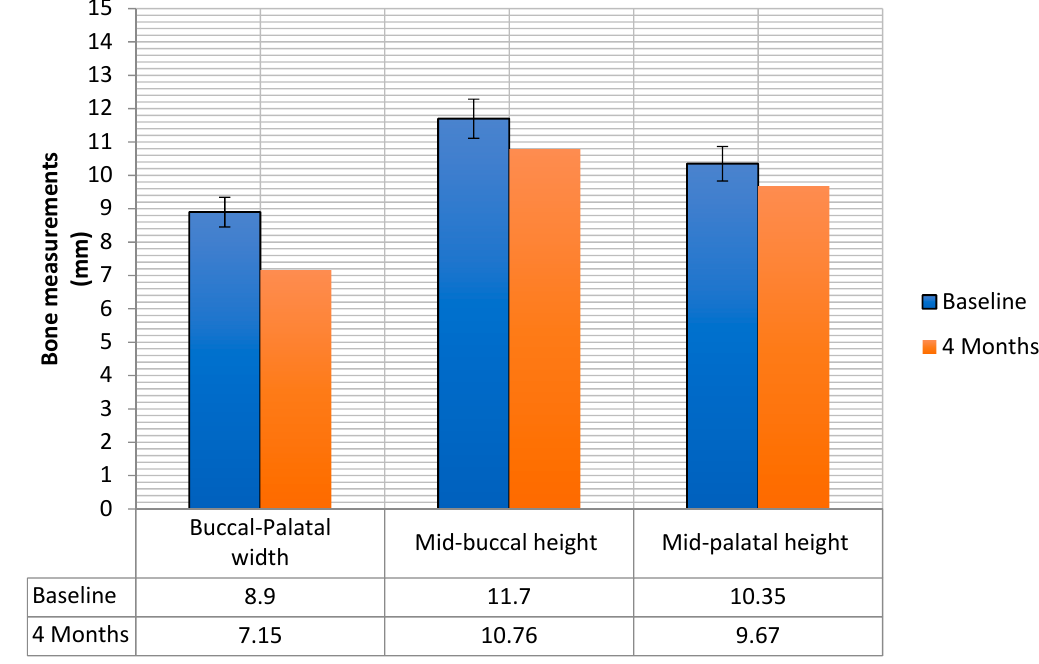
Chart 1. Dimensional changes in the ridge width and height at four months after the Chart 1: Dimensional changes in the ridge width and height at four months after the procedure.